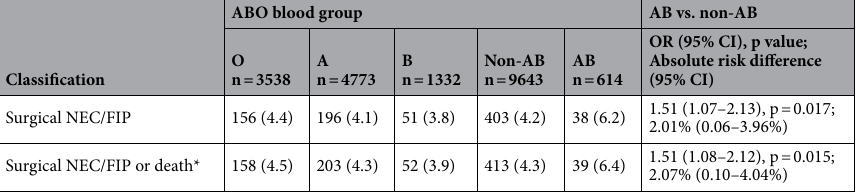
Table 2. Risk for surgical NEC/FIP in relation to blood group. Values in blood group are given as n (%). NEC necrotizing enterocolitis, FIP focal intestinal perforation, Pearson´s χ 2 test, OR odds ratio, CI confidence interval. *Patients with NEC/FIP in Bell stage ≥ 2° undergoing surgical intervention (n = 441) or death without surgery related to NEC/FIP (n = 11).